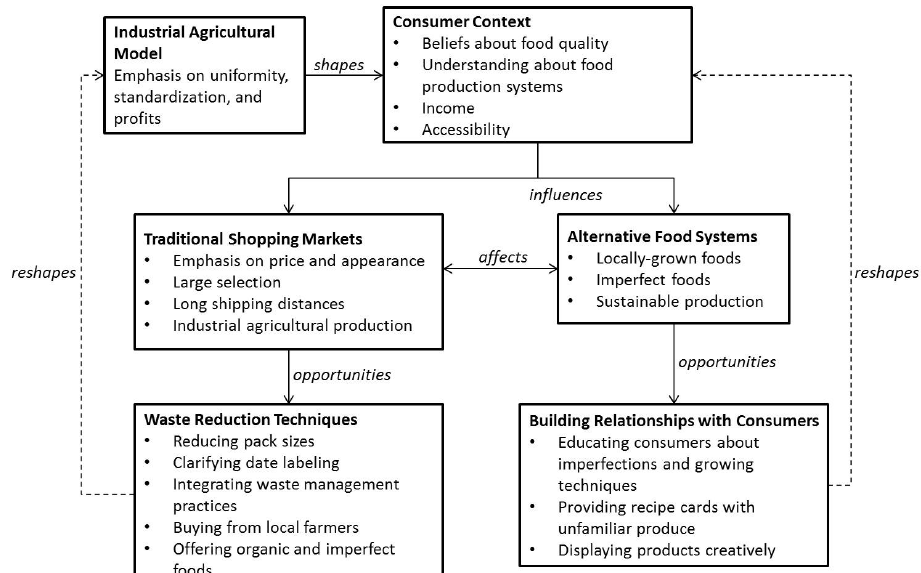
Figure 1 . Conceptual model of consumer perceptions of fresh produce quality and retail practices in Fredericksburg, Virginia, USA. Figure by